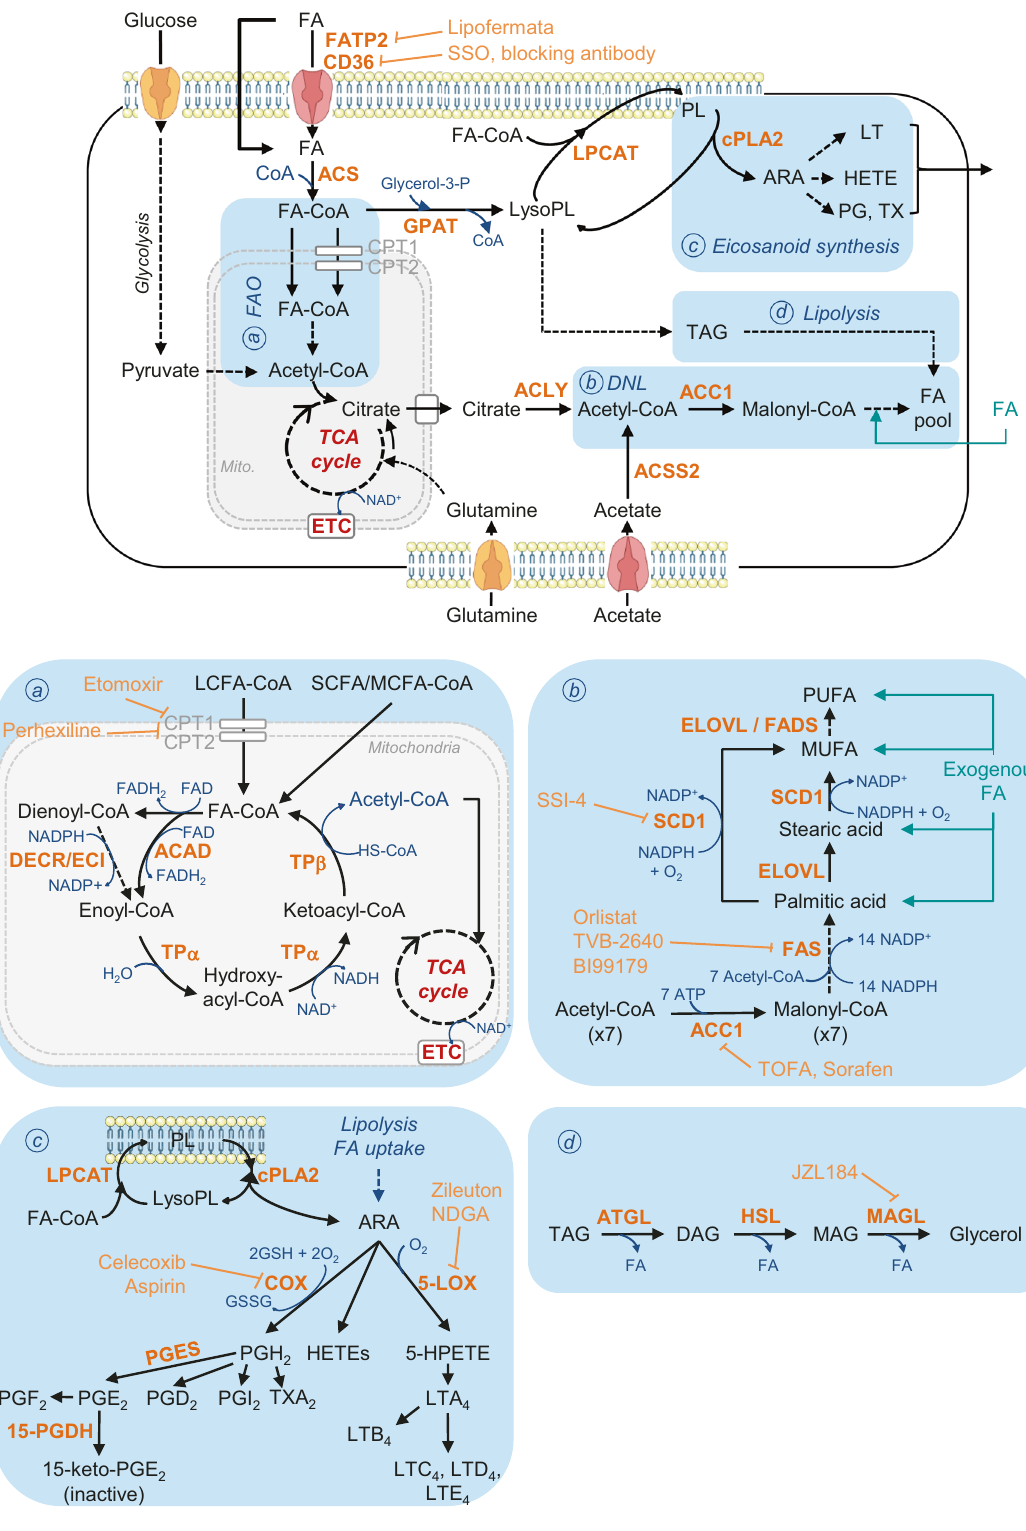
cells from their environment, such as FA translocase (FAT or CD36), and FA transport protein (FATP) or in the intracellular transport of FAs, such as plasma membrane FA-binding protein (FABP) [7]. Nieman et al. have demonstrated that, during early stages of metastatic cascade, FABP4 promotes detachment and